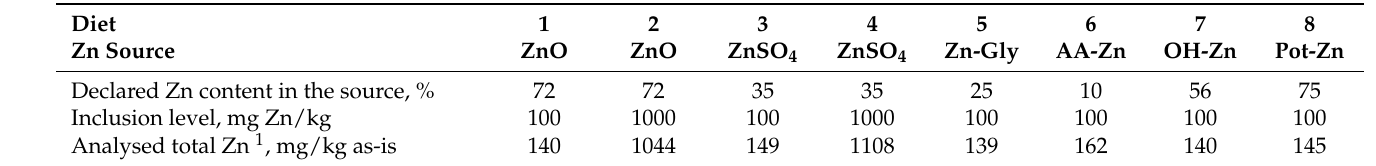
Table 2. Sources and levels of Zn tested, the declared Zn content in the Zn source and the total analysed Zn content in the eight